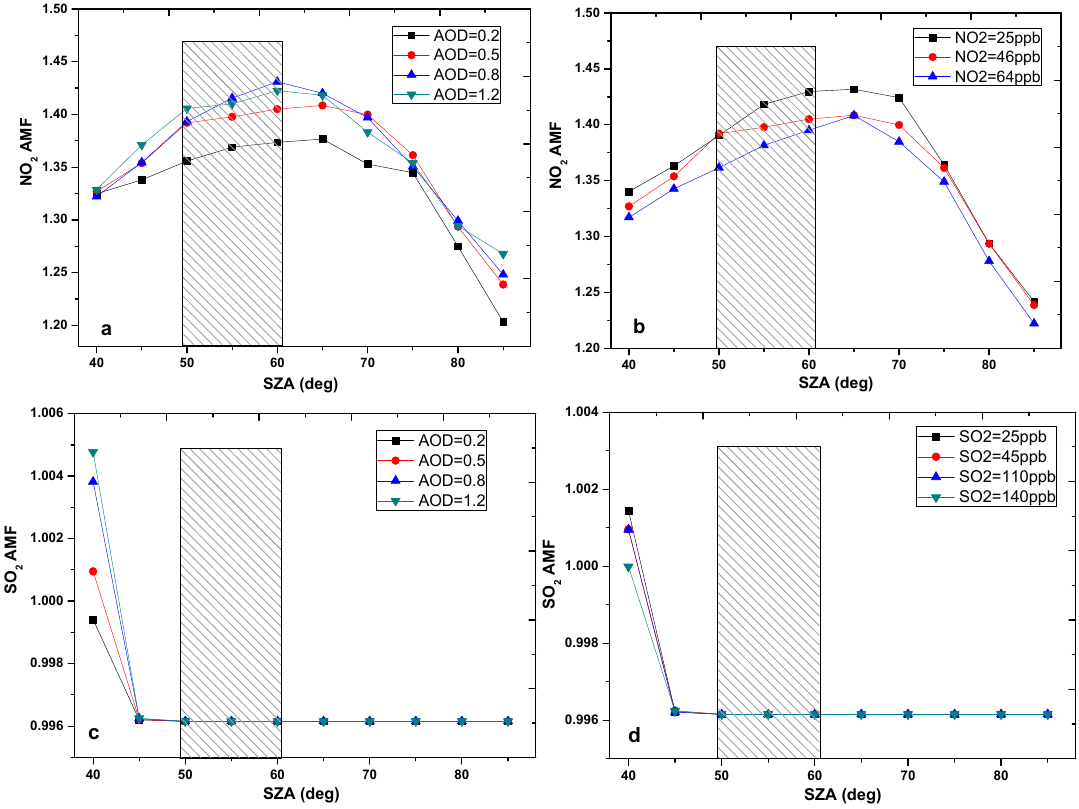
Figure 4. Simulated AMF for different aerosol and trace gas profiles. The rectangle regarding the solar zenith angle (SZA) is the time of mobile DOAS observations. ( a ) NO 2 AMF simulation in the scenarios of different SZAs and aerosol optical density (0.2, 0.5, 0.8 and 1.2); ( b ) NO 2 AMF simulation in the scenarios of different SZAs and NO 2 concentration (25 ppb, 46 ppb and 64 ppb) ( c ) SO 2 AMF simulation in the scenarios of different SZAs and aerosol optical density (0.2, 0.5, 0.8 and 1.2); ( d ) SO 2 AMF simulation in the scenarios of different SZAs and SO 2 concentration (25ppb, 45 ppb, 110 ppb and 140 ppb).